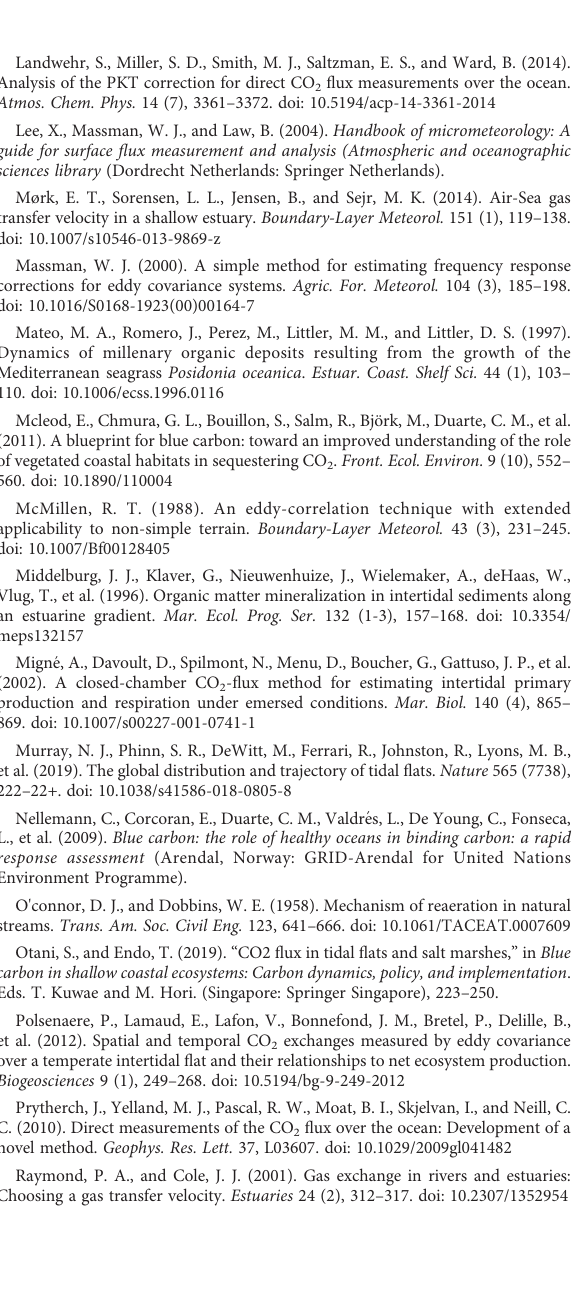
SUPPLEMENTARY FIGURE 1 Temporal variations of water temperature, salinity, air temperature, wind speed, water depth, PAR, current speed, and O 2 concentration during the